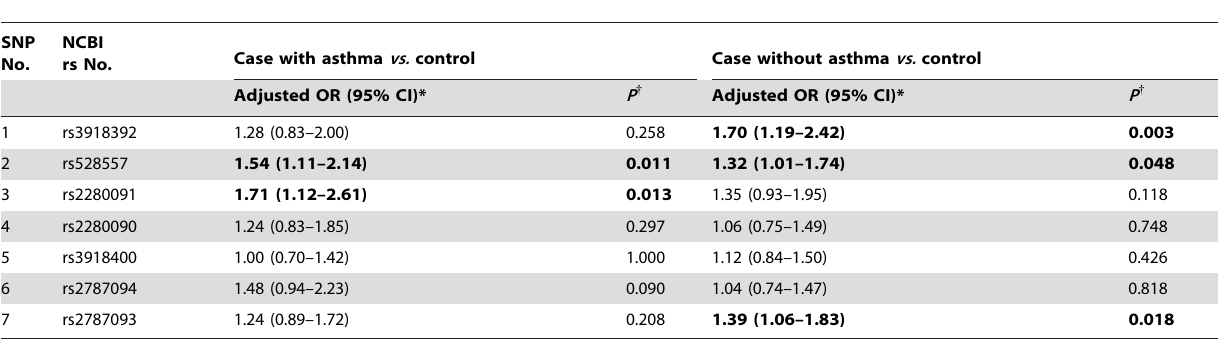
Table 5. Genotype frequencies of ADAM33 polymorphisms in dominant model in PER patients with and without asthma.